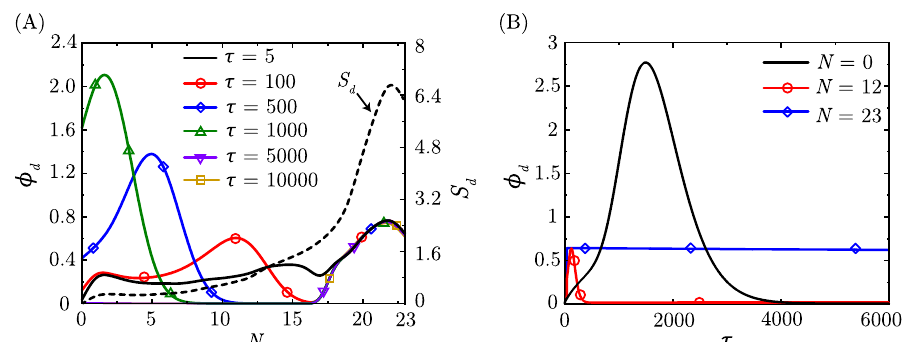
R R � L 0 d 8 d t ) within the lungs at the end of exposure and drug concentration d D